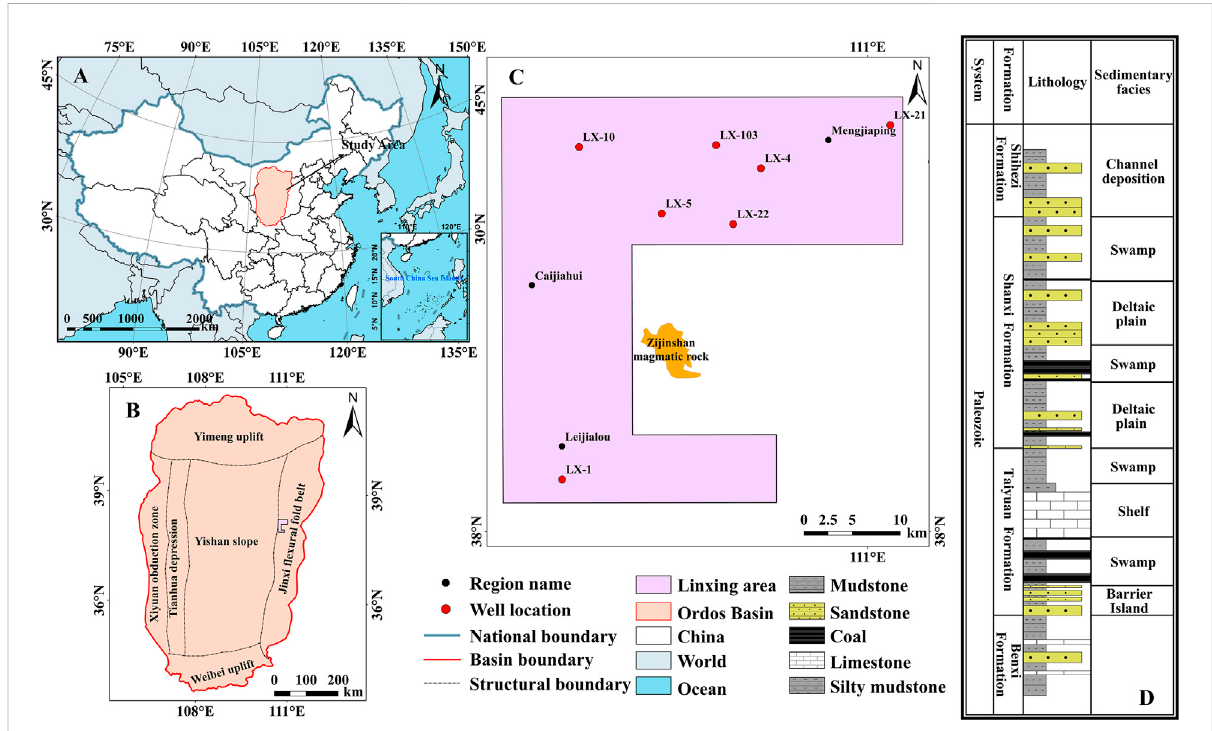
FIGURE 1 Geological settings of the Ordos Basin: (A) showing the location of the Ordos Basin; (B,C) showing the location of Linxing area and sampling well; (D) stratigraphic histogram of Shihezi Formation-Benxi Formation in Linxing area, modi fi ed after Li et al.